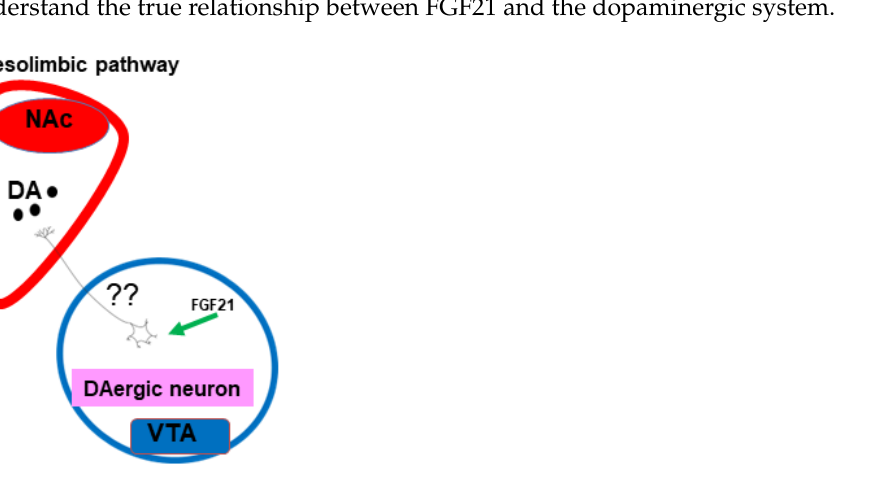
Figure 4. Implications of FGF21 in the mesolimbic system: Abbreviations used: DA: dopamine; NAc: nucleus accumbens. FGF21: fibroblast growth factor-21; VTA: ventral tegmental area.